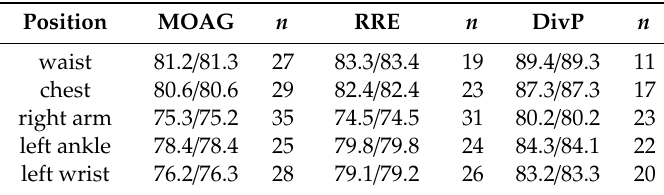
Table 17. Performance comparison (Accuracy / F1%) and number of ELMs after pruning achieved by comparative algorithms.